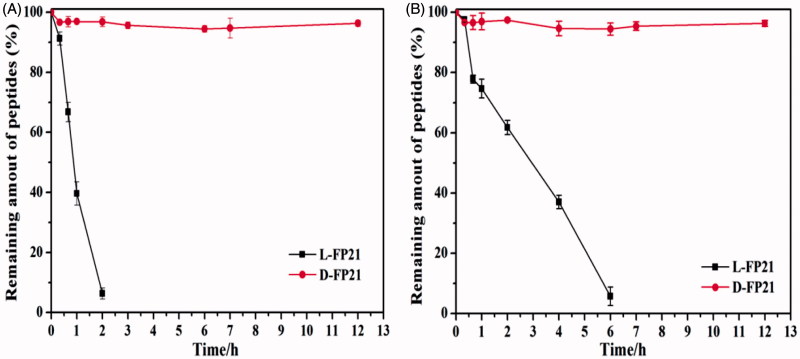
Stability of peptides in rat serum (A) and aminopeptidase M (B).